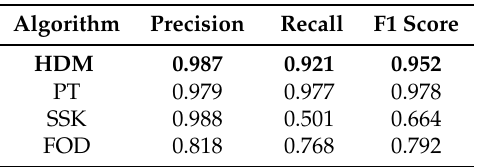
Table 2. Performance of the heartbeat-detection module (HDM), the Pan and Tompkins algorithm (PM), Saini, Singh and Khosla algorithm (SSK), and the algorithm based on the first order difference technique (FOD) in terms of precision, recall, and F1